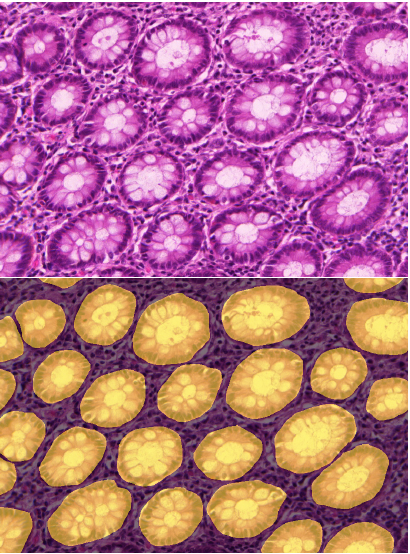
Figure 1. A histological image of colon mucous glands and glands annotation